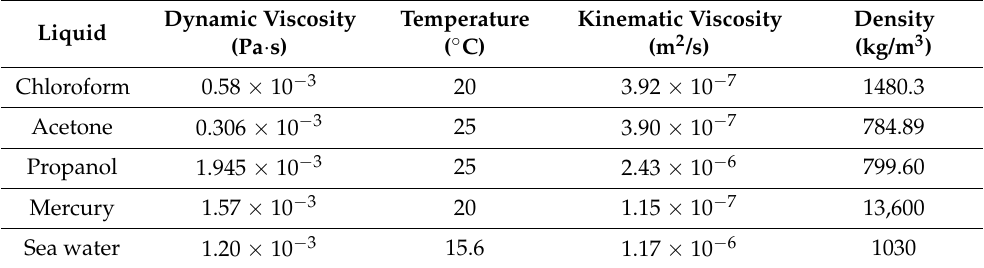
Table 2. TLD liquid